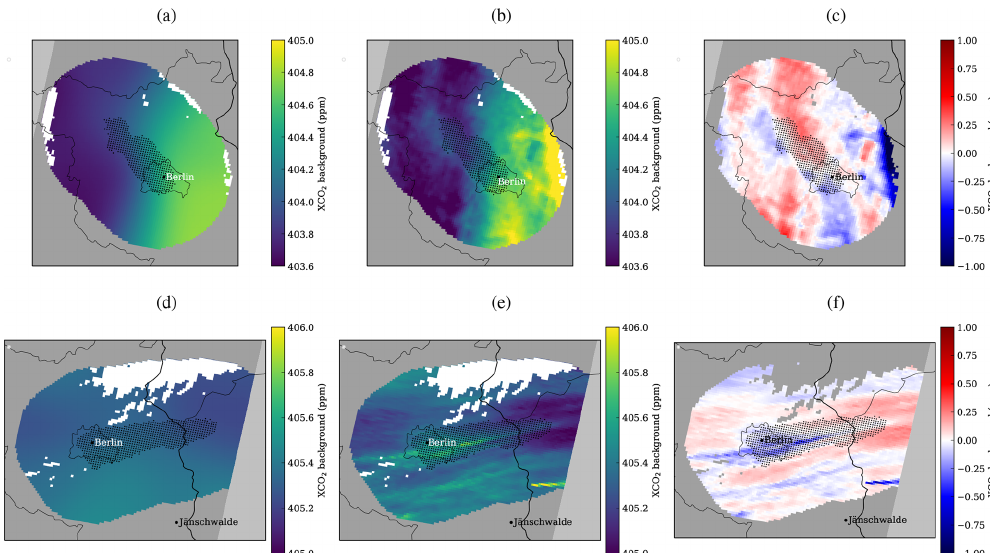
Figure 10. (a) Estimated background, (b) true background, and (c) difference between estimated and true background for 27 February 2015. Black dots show the CO 2 plume detected from the NO 2 observations. Mean bias (MB) and standard deviation (SD) within the detected plume are − 0.03 and 0.11ppm. (d–f) The same as (a–c) but for 23 April 2015 with MB and SD of 0.04 and 0.11ppm, respectively. Note that MB and SD are much smaller than the noise of the measurements. The effective wind speeds within the plumes are 2 and 6ms − 1 ,